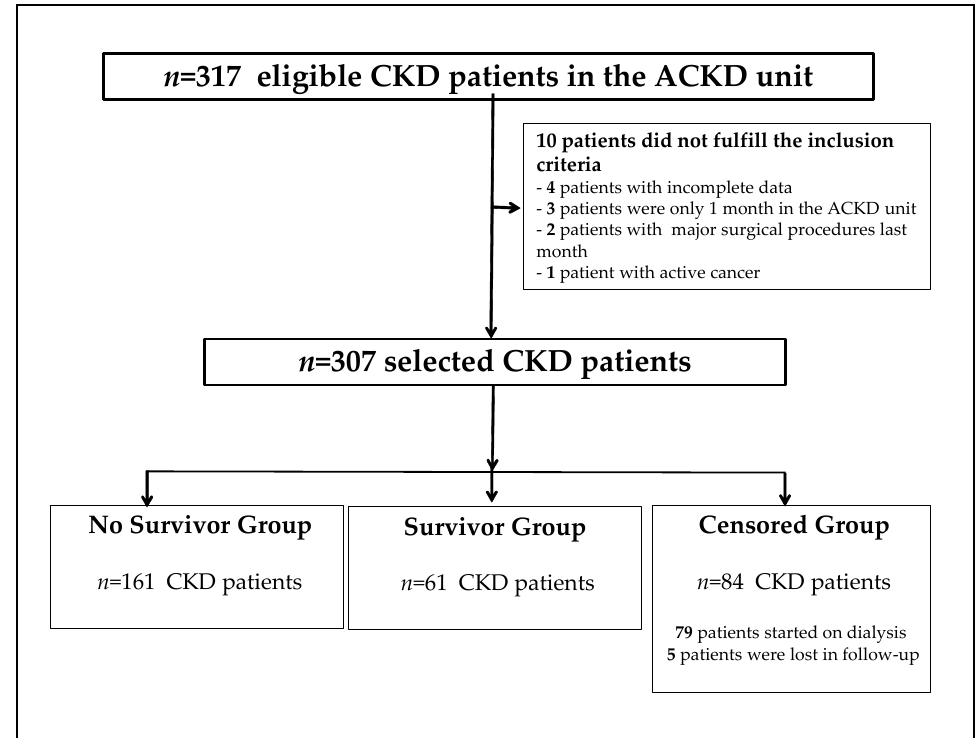
Figure 1. Flowchart of the recruitment and selection of chronic kidney disease patients in the study. ACKD unit, advanced chronic kidney disease unit; CKD, chronic kidney disease.